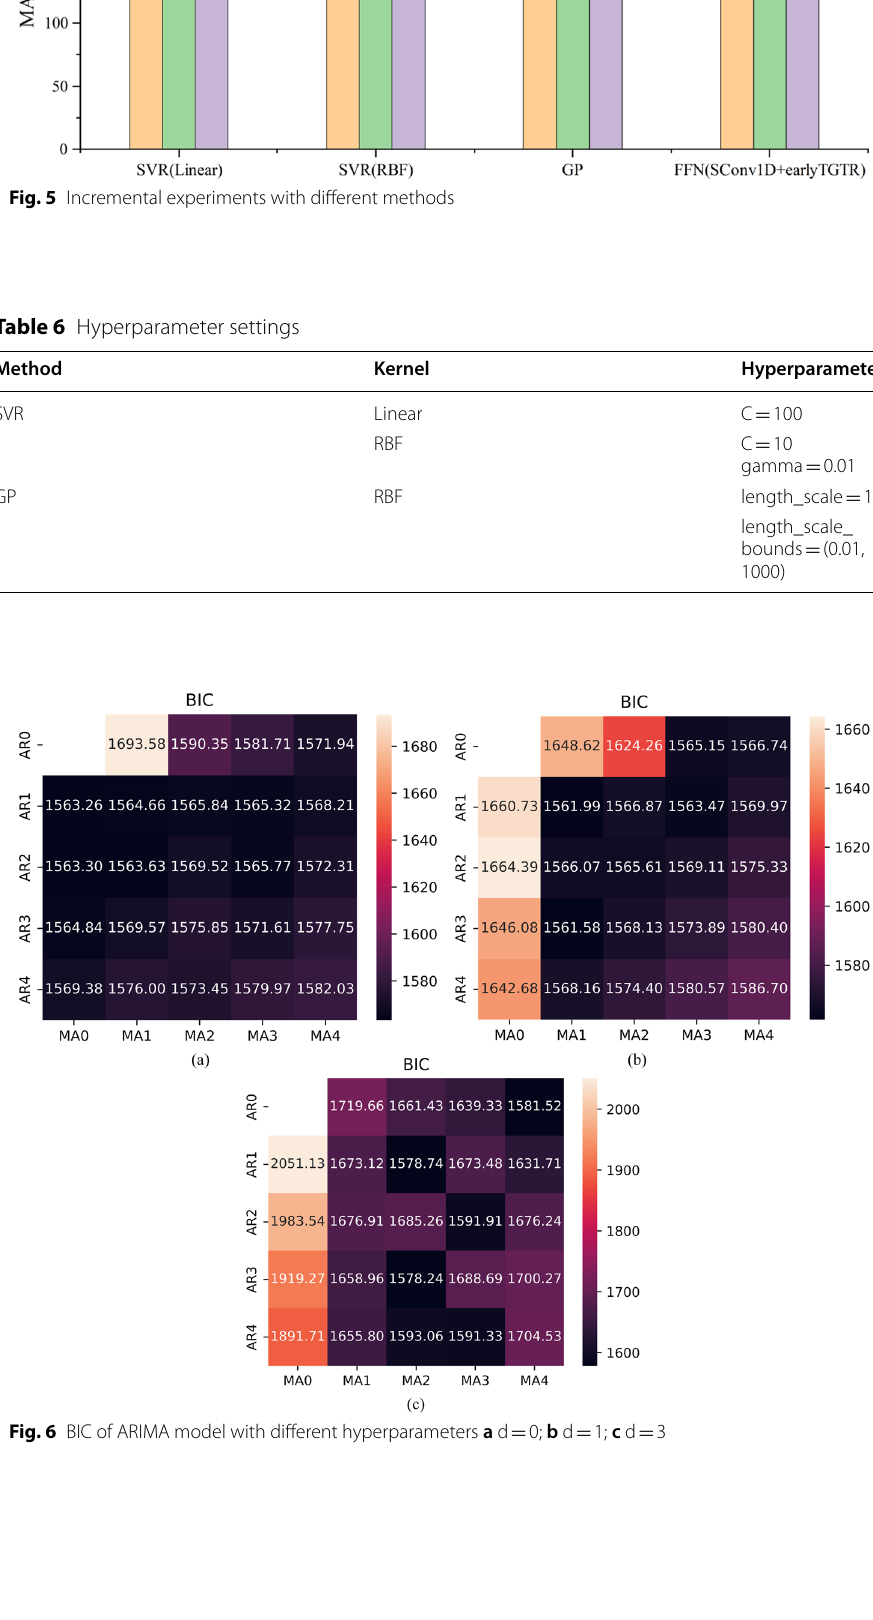
Fig. 6 BIC of ARIMA model with different hyperparameters a d